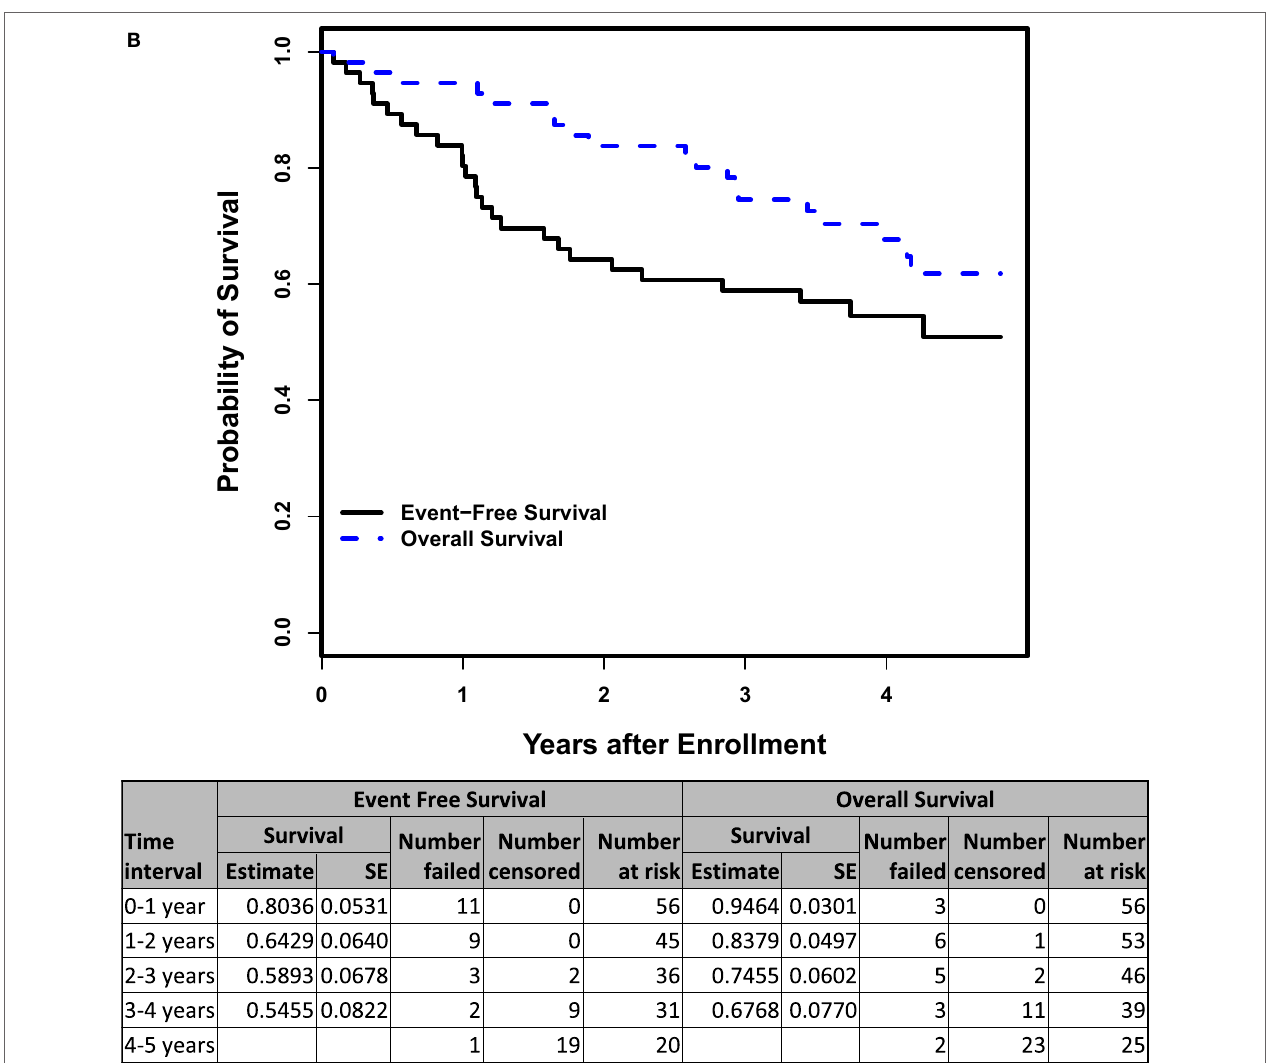
FiGUrE 3 | (a) Event-free and overall survival (OS) from time of enrollment for patients on COG ANBL0931 ( n = 105). (B) Event-free and OS from time of enrollment for patients > 18 months of age with INSS Stage 4 disease on COG ANBL0931 ( n =